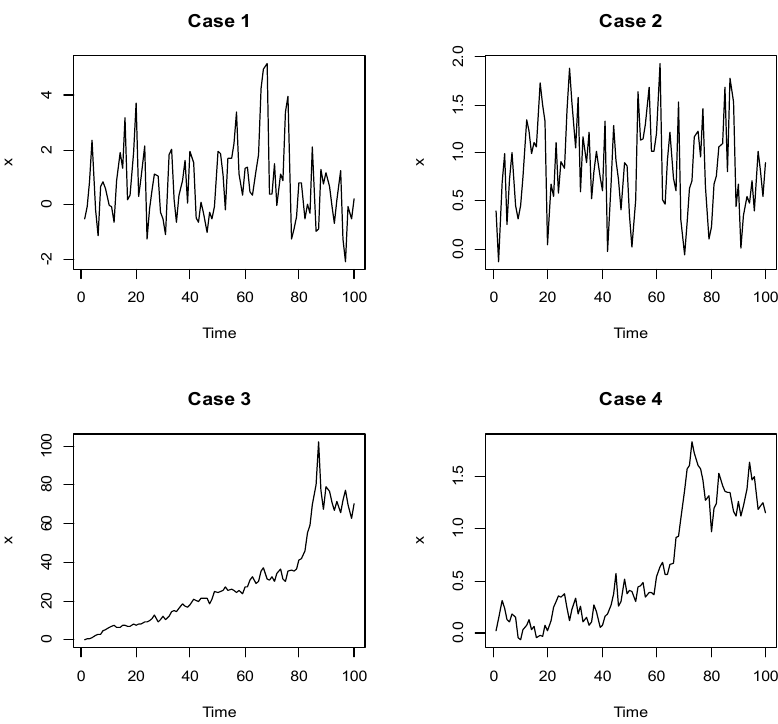
Figure 1. The time series plot of Case1–4 for generated data (100 sample sizes).